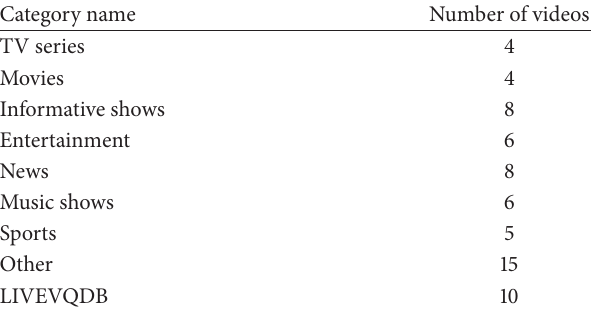
Table 1: Distribution of videos in the test